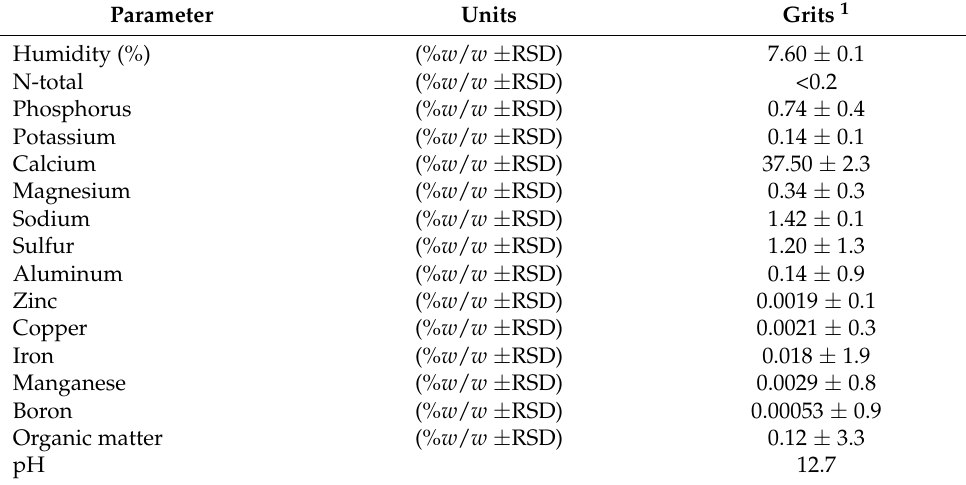
Table 1. The chemical and physical characterization of the